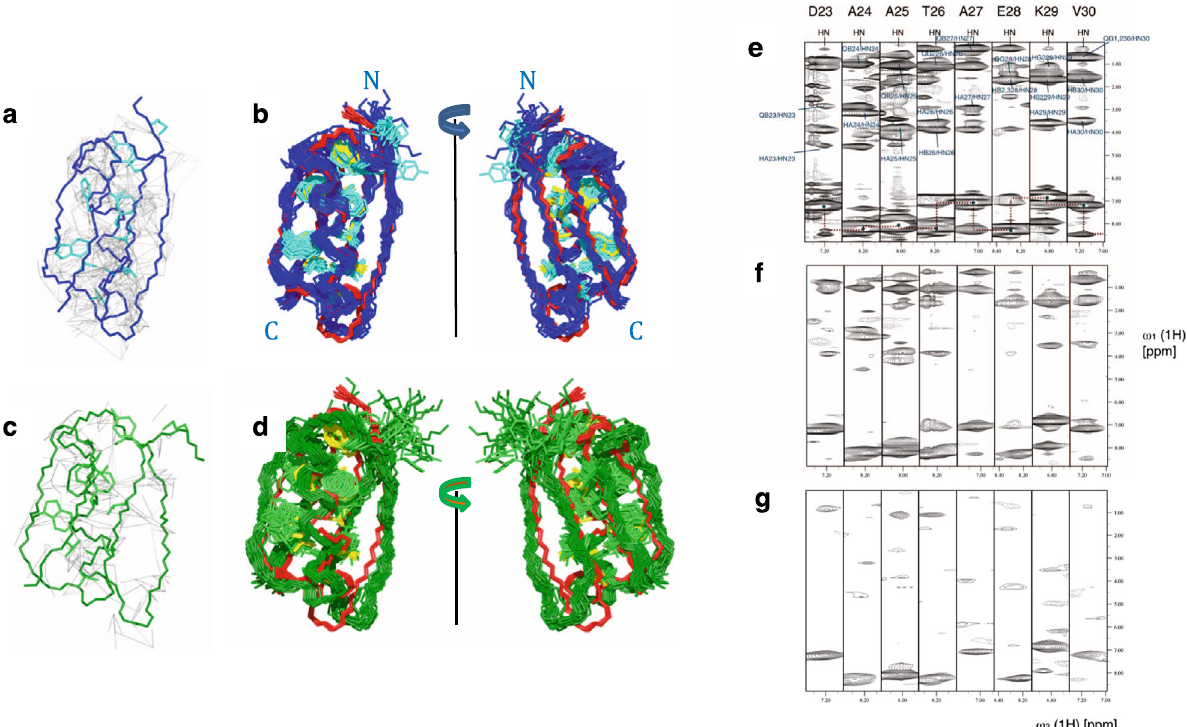
Fig. 4 Structure determination in mammalian cells. a , b The 3D NMR structures of GB1 in cells at a protein concentration of 50 μ M and ( c , d ) at a concentration of 10 μ M. In a and c the NOE-derived distance restrains are shown in grey on top of a representative conformer of the calculations. The backbone of the structure is shown in blue and green, while the most buried side chains are colored more light (i.e. cyan or light green). In b , d the two calculated structures are shown in the bundle representation comprising 20 conformers highlighting the RMSD of the structure calculation. The same coloring as in a , c is used. In addition, the 3D in vitro NMR structure with the PDB code 2N9K.pdb is superimposed to the in-cell structures and color coded in red for the backbone and in yellow for the buried side chains. Again 20 conformers are shown representing the 3D structure quality. e – g 15 N, 13 C-resolved [ 1 H, 1 H]-NOESY spectra of e reference GB1 in vitro, f in cell at 50 μ M concentration and g in cell at 10 μ M. The HN/N strips of residues D23-V30 are shown as indicated. In e the intra residual assignment is depicted in blue, the diagonal peaks are indicated by a blue circle, and the anticipated sequential walk from HN to HN is indicated by red dotted lines. It is evident that a signi fi cant signal loss is observed from e to f and a further vast signal loss is observed from f to g